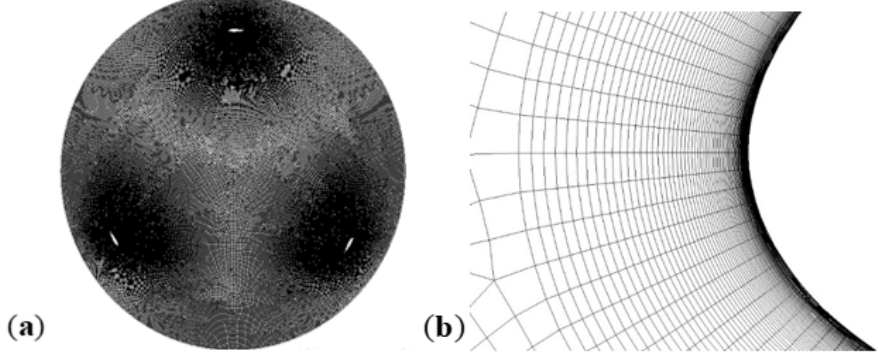
Figure 2. ( a ) Grid detail in rotor zone and ( b ) zoom on the leading edge of the hydrofoil.